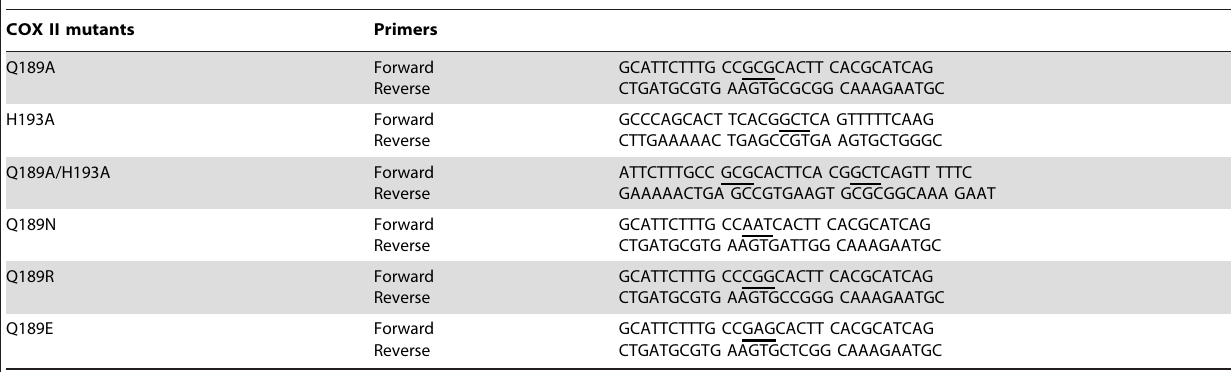
Table 3. Primers used in the site-directed mutagenesis